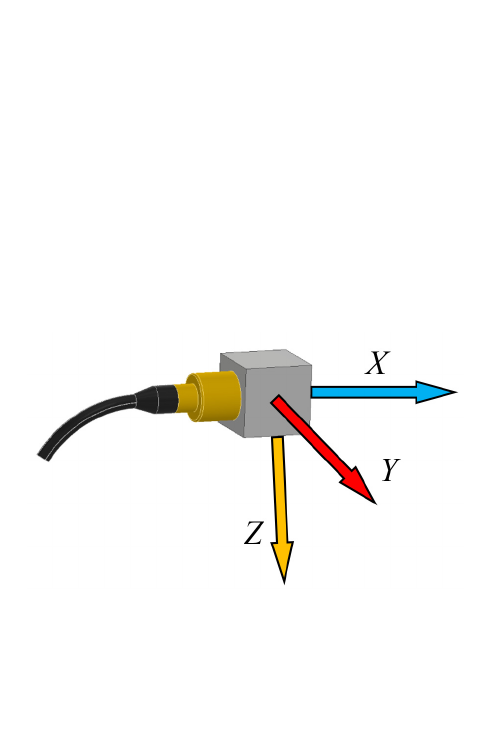
Figure 7. Measuring chain for measuring acceleration.